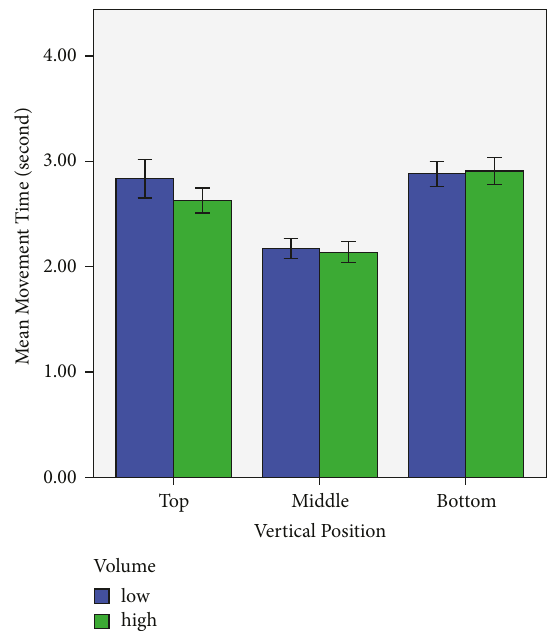
Figure 10: Mean movement time for vertical positions × volume.